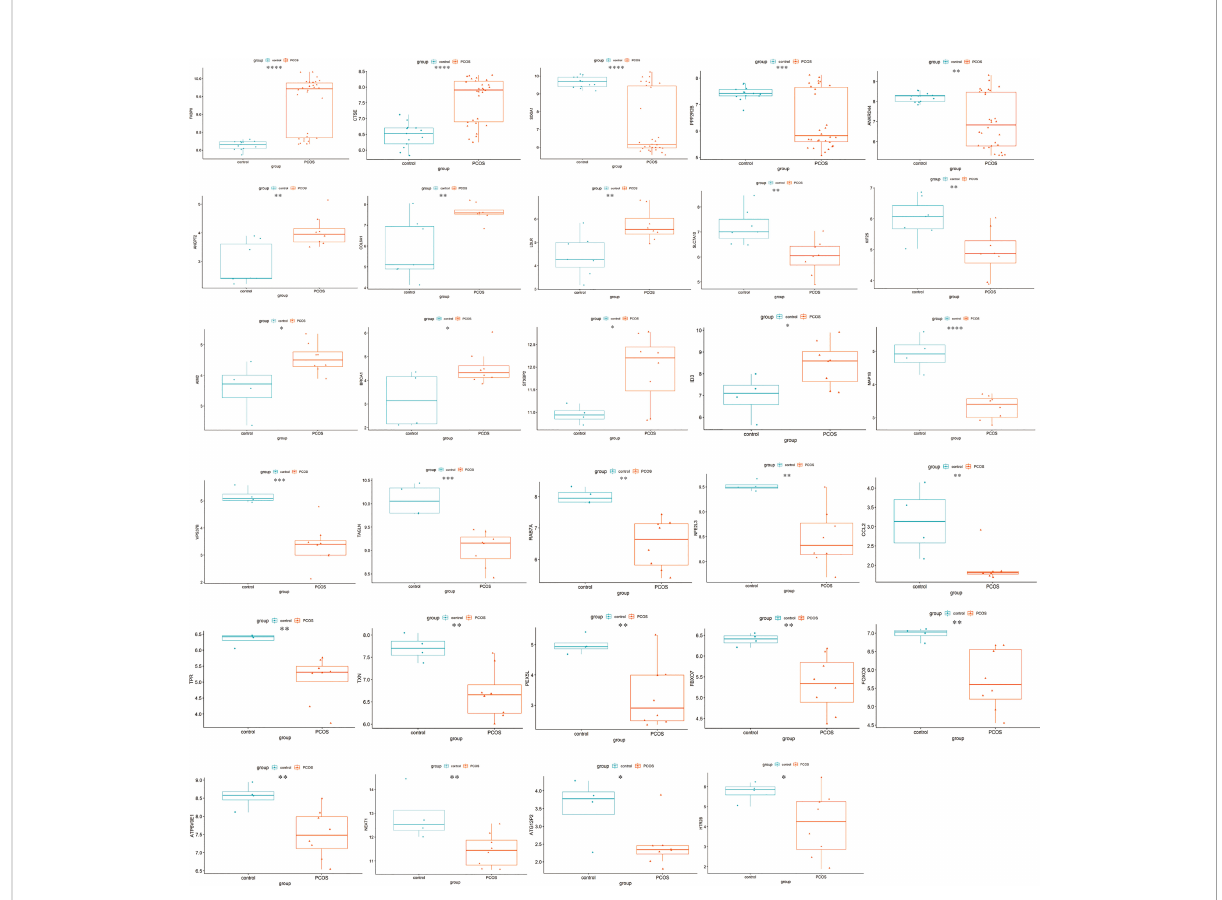
FIGURE 5 Differential expression of hub ATGs. The box plots showed the differential expression of hub ATGs between women with and without PCOS in GSE51981, GSE43264, and GSE106724. p<0.05 was considered statistically signi fi cant. ****: p < 0.0001, ***: p < 0.001, **: p < 0.01, *: p <